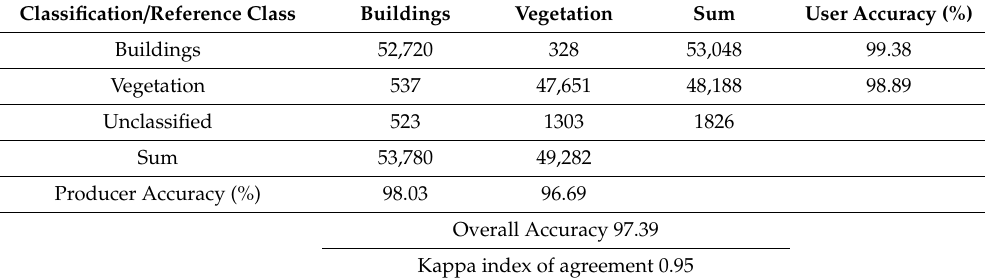
Table 5. Confusion matrix for object-based image